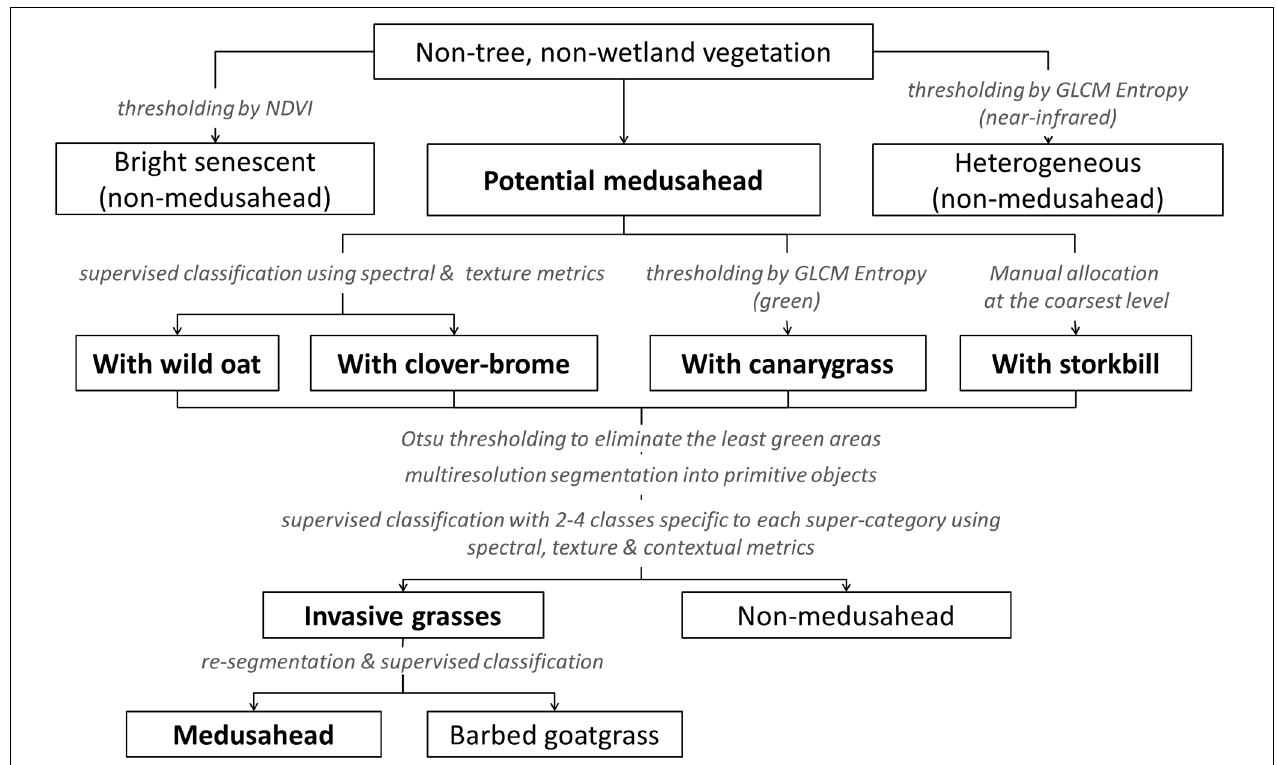
FIGURE 3 | Major classes and steps in the knowledge-based hierarchical classification of medusahead.